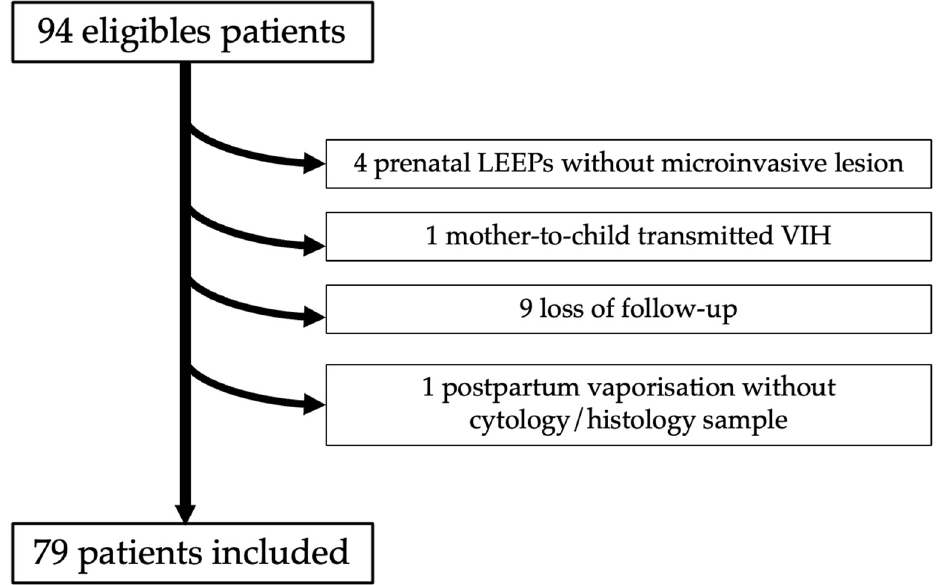
Figure 1. Flow-chart of population study.